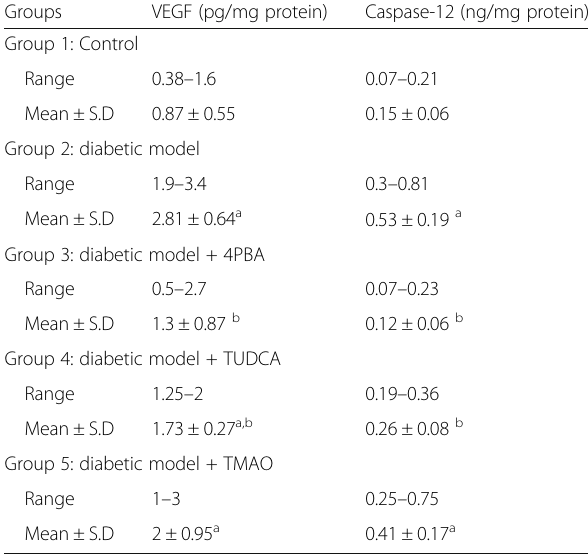
Table 5 Lens vascular endothelial growth factor (VEGF) and caspase-12 in control and experimental